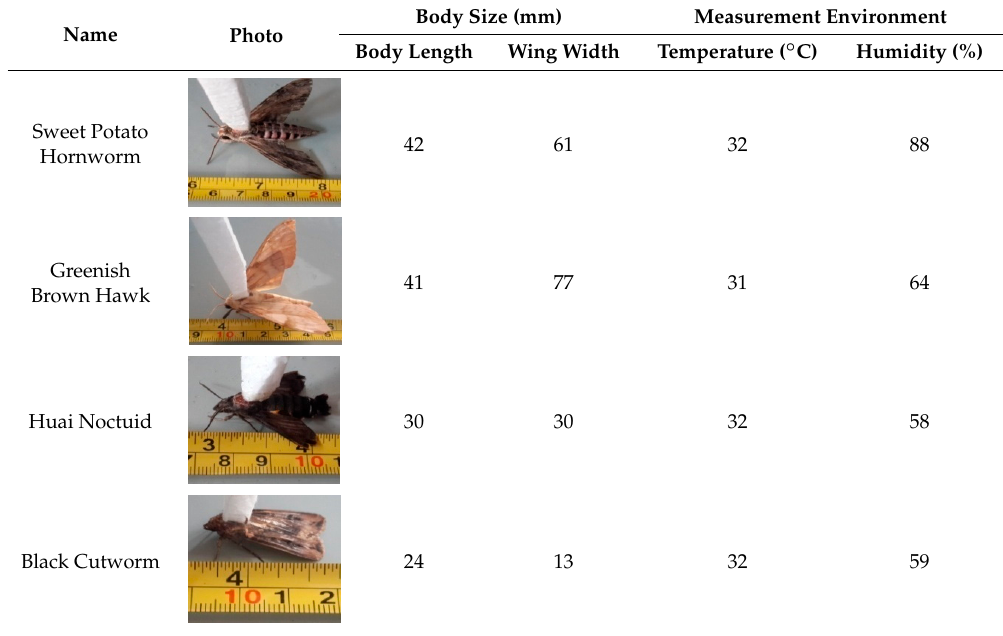
Table 2. Insects’ information in the anechoic chamber experiments.